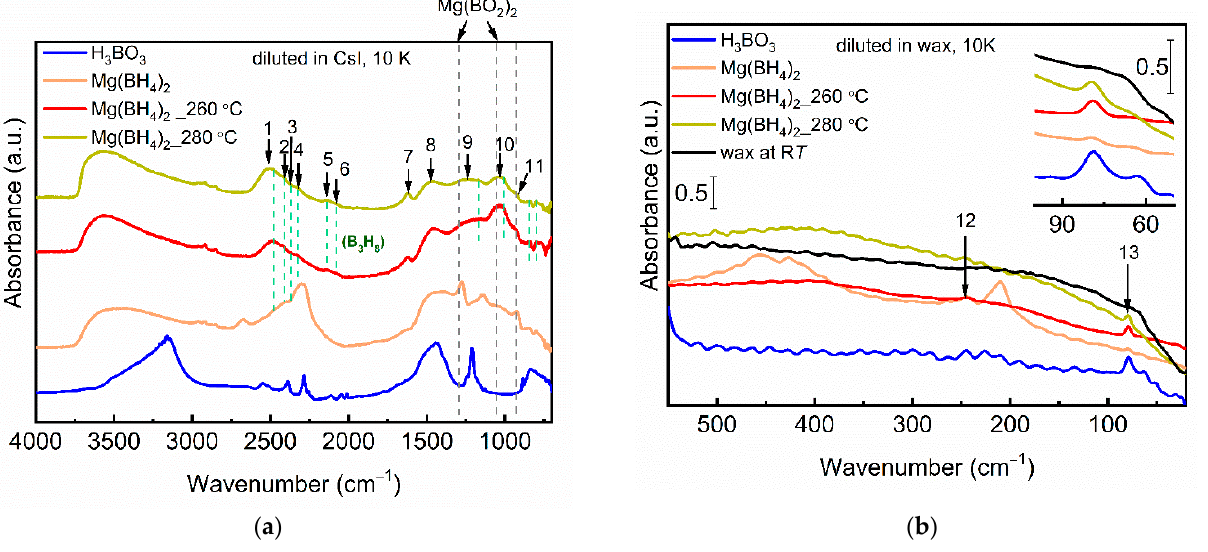
Figure 3. ( a ) Mid-IR spectra of pristine and partially decomposed Mg(BH 4 ) 2 . The spectrum of H 3 BO 3 is also reported for comparison. The spectra are recorded at 10 K. The modes expected for (B 3 H 8 ) − are illustrated according to the reference [23] ; ( b ) Far-IR spectra recorded at 10 K of pristine and partially decomposed Mg(BH 4 ) 2 . The spectra of H 3 BO 3 and of the diluent (wax) is also reported for comparison. The inset shows the region around the band at 70 cm − 1 associated with boric acid (borate). The assignment for the modes 1–13 is given in Table 4.